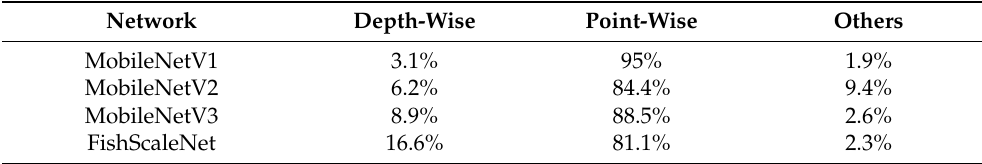
Table 2. Computational complexity distribution of MobileNetV1-V3 and FishScaleNet.